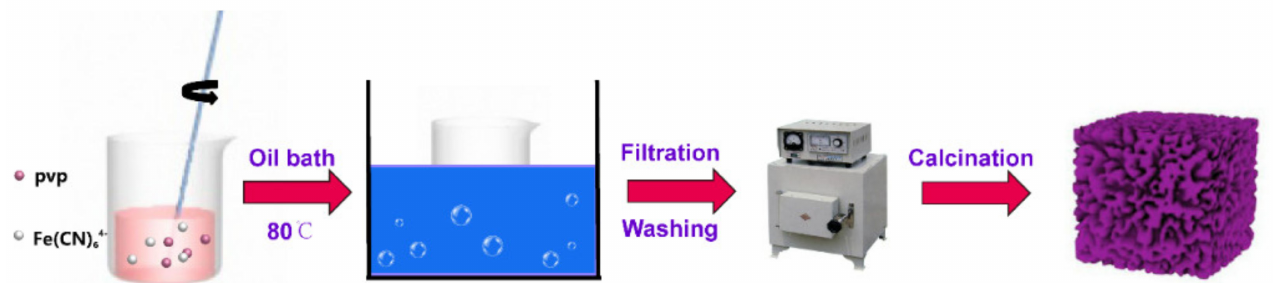
Figure 1. Schematic of the synthesis of Fe 2 O 3 microcubes.